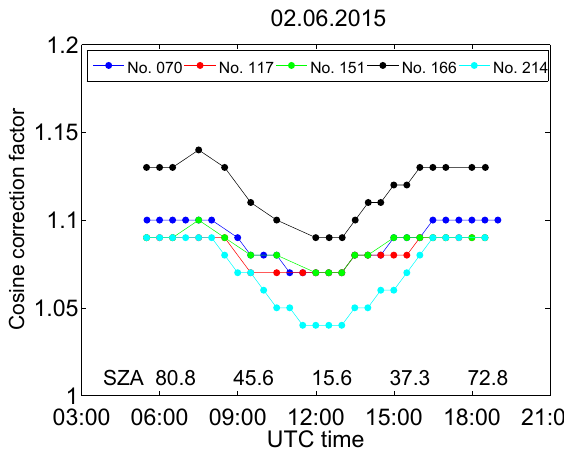
Figure 4. Diurnal variation of the cosine error correction factor of Brewers no. 070, no. 117, no. 151, no. 166 and no. 214 at 308nm on 2 June 2015. The x axis is time (UTC), but SZAs are shown for 06:00, 09:00, 12:00, 15:00 and